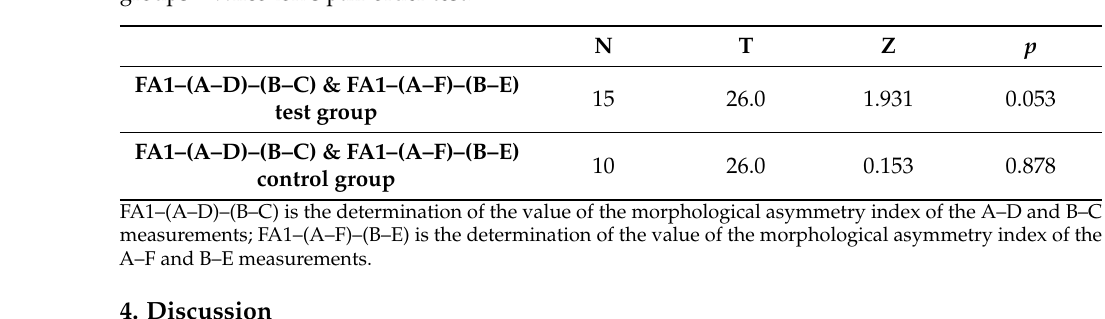
Table 8. The difference in the severity of morphological asymmetry of the studied features within groups—Wilcoxon’s pair order